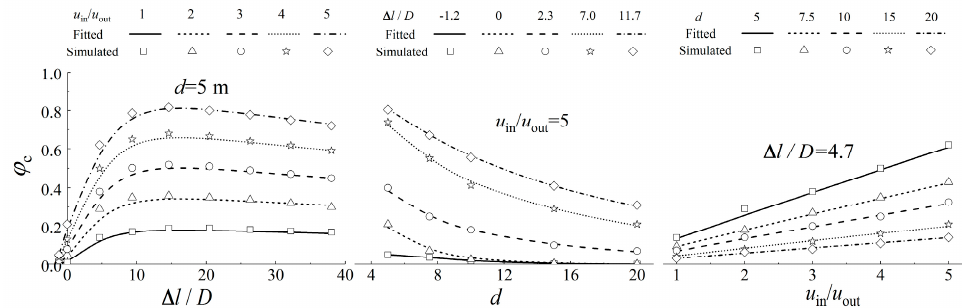
Figure 14. Comparison of calculated circulating air mixing ratio φ c with simulated results.